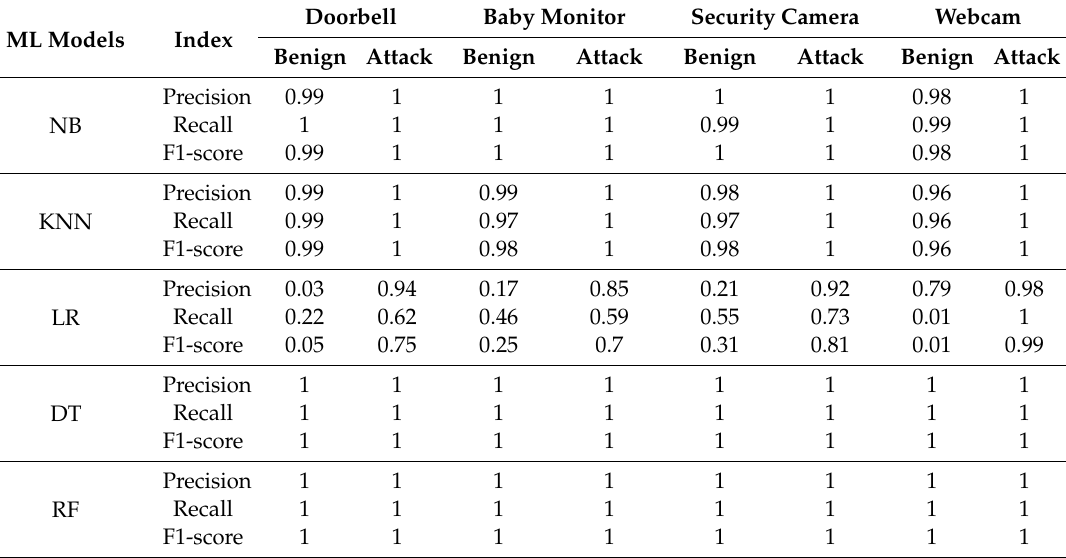
Table 9. Detection results of the five ML